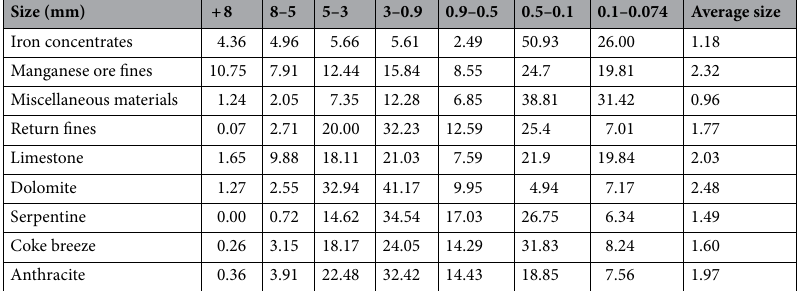
Table 2. Size distributions of all of the raw materials (mass%).